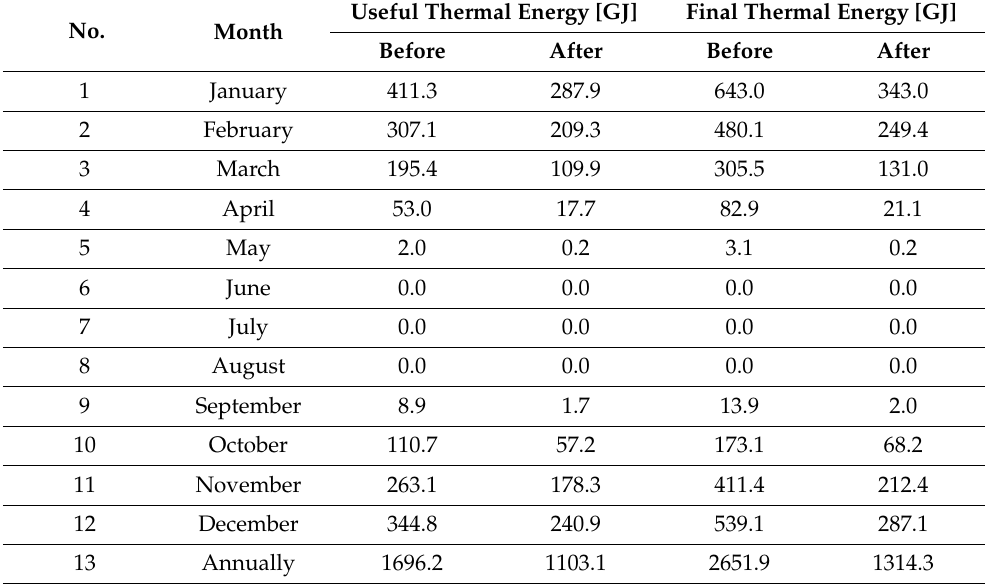
Table 7. The results of the theoretical calculations of the monthly consumption of useful thermal energy and final thermal energy in the tested building before and after thermomodernization. Useful Thermal Energy [GJ] Final Thermal Energy [GJ] No. Month Before After Before After 1 January 411.3 287.9 643.0 343.0 February